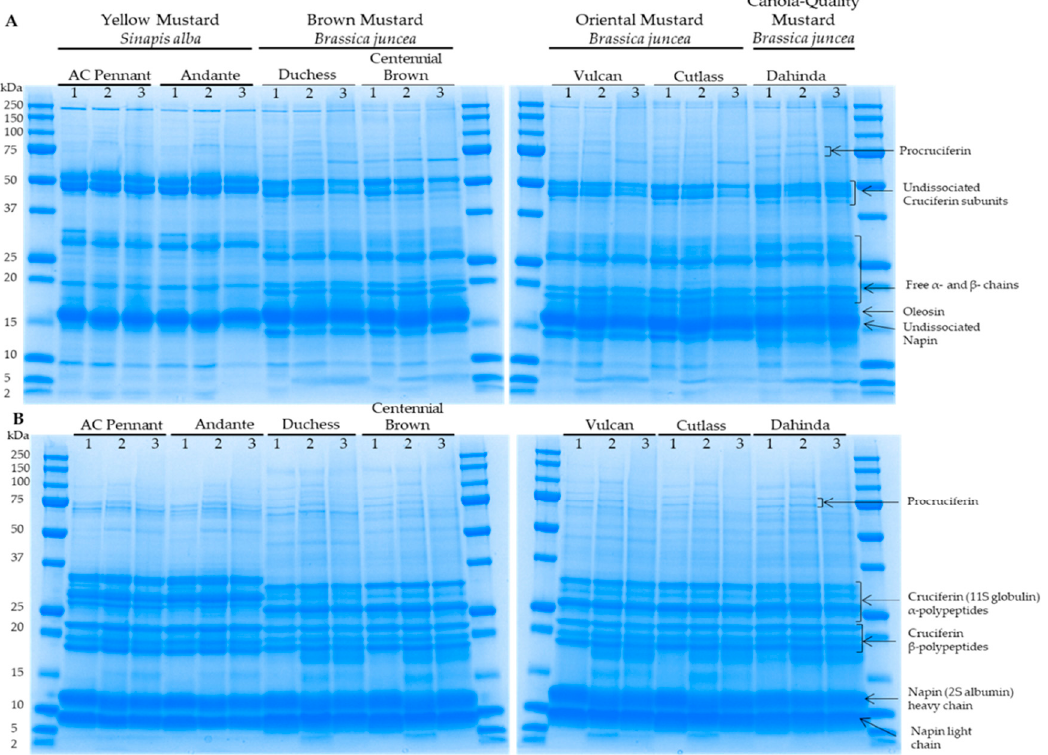
Figure 2. Protein electrophoretic profiles of mustard seed varieties as a function of extraction buffer. Proteins were separated under non-reducing ( A ) and reducing ( B ) conditions. 1: phosphate buffer; 2: borate buffer; 3: carbonate buffer. Molecular weights (MWs) of the standards are indicated in the left margin.